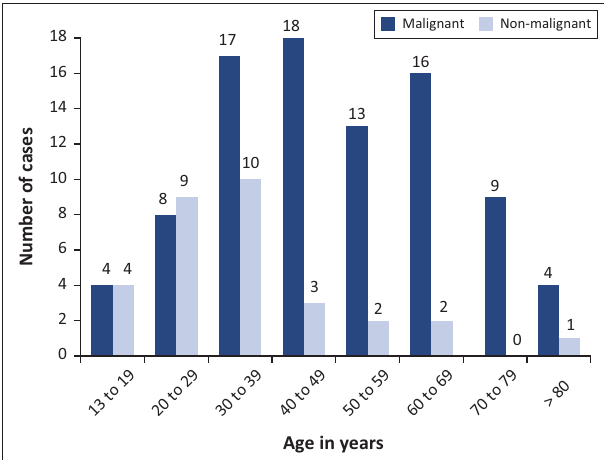
FIGURE 1: Distribution of malignant and non-malignant conditions according to age groups of 120 bone marrow aspirates and trephine biopsies performed at a hospital in KwaZulu- Natal, South Africa, January 2016 to December